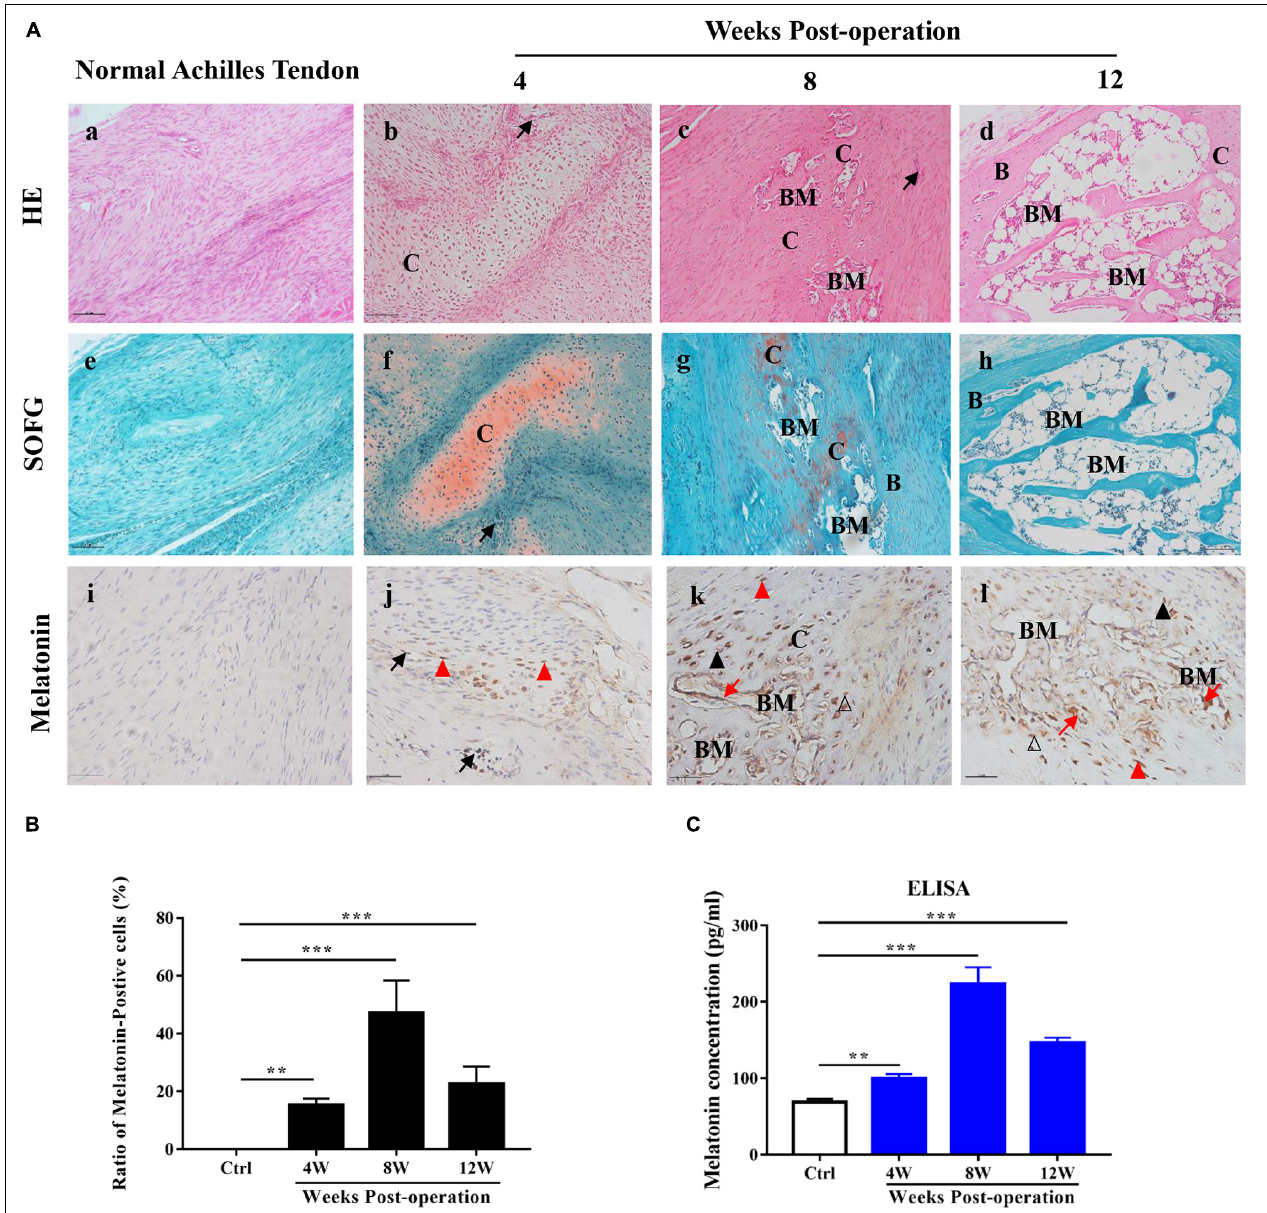
FIGURE 1 | Melatonin in HO formation in rats with Achilles tendon injuries. (A) HE and SOFG staining of normal Achilles tendons (a,e) and HO specimens at 4, 8, and 12 weeks after the operation (b–d,f–h) . The occurrence of HO was seen at 8 weeks after the operation. Proteoglycan (red) and ectopic bone (green). Immunohistochemical staining of melatonin (brown) in normal Achilles tendons (i) and HO specimens at 4, 8, and 12 weeks after the operation (j–l) . IHC showed that melatonin was expressed in vascular endothelial cells, infiltrating mesenchymal cells, chondrocytes, osteoblasts and newly formed bone marrow cells. B, bone; BM, bone marrow; C, cartilage; Me, mesenchyme, black arrows point to vessel endothelial cells, red triangles point to infiltrating mesenchymal cells, black triangles point to chondrocytes, blank triangles point to osteoblasts and red arrows point to newly formed bone marrow cells. Scale bar, 10 µ m. (B) The number of melatonin-positive cells in injured Achilles tendon specimens at the indicated time points. (C) Serum concentrations of melatonin from normal rats or rats with Achilles tendon injuries at different time points. The data represent the mean ± SD. ** P < 0.01, *** P < 0.001 versus the normal